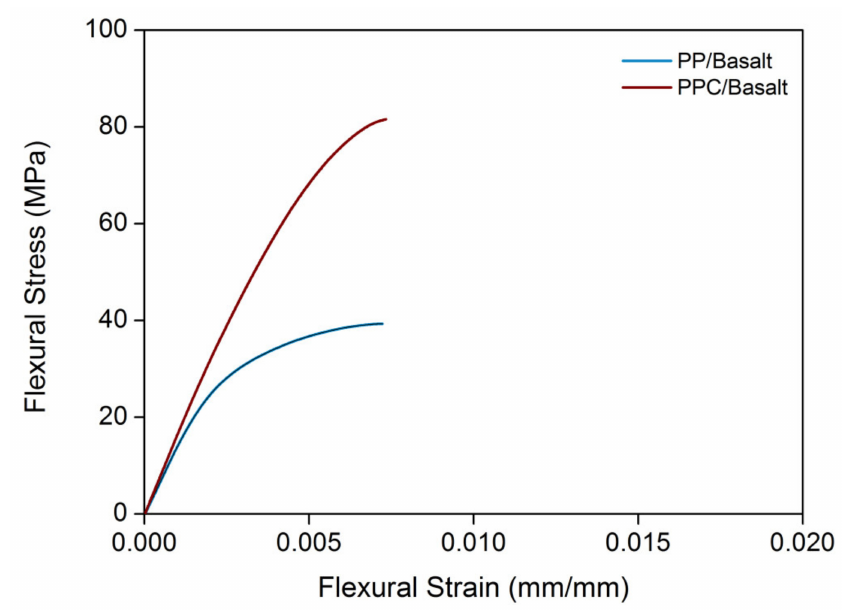
Figure 2. Flexural stress–strain curves. Table 1. Flexural stress–strain